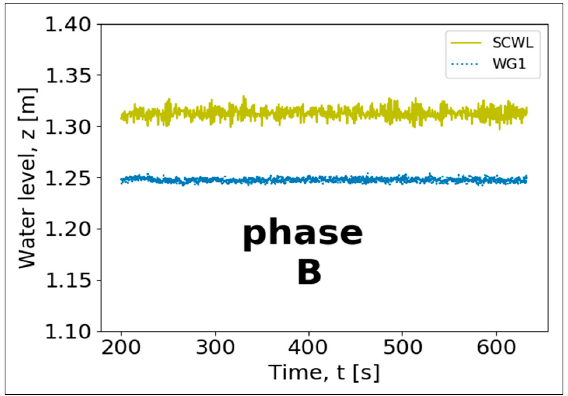
Figure 14. Secondary channel water level (SCWL) and WG1 measurements during the current stabilization phase B of Test 04_B.